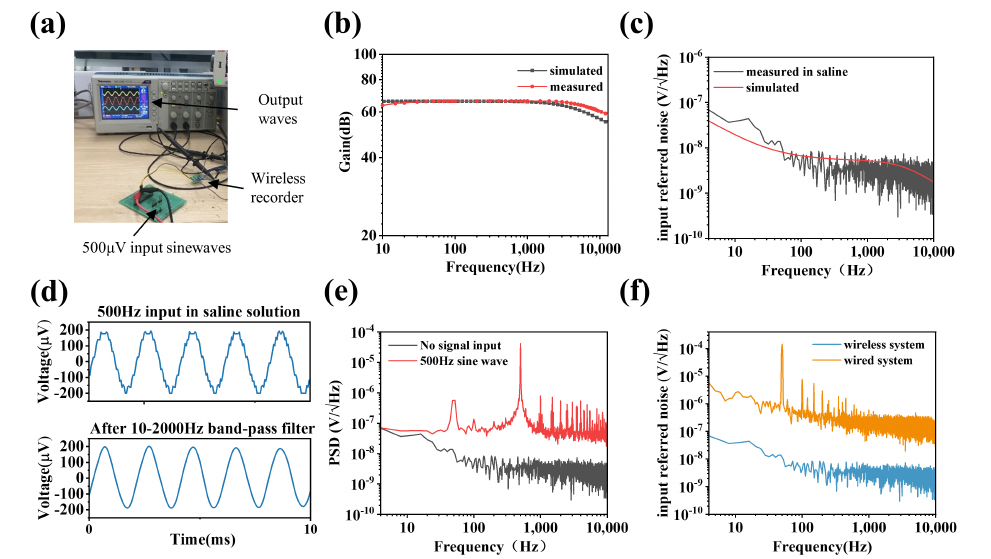
Figure 5. The electrical properties of wireless neural recording microsystem. ( a ) The transfer function test environment. ( b ) Transfer function measured and simulated of the dual op − amps full differential neural recording front end. ( c ) Input referred noise measured of the wireless neural recording microsystem in saline solution and compared with the simulation. ( d ) The waveform of recorded 500 Hz, 2 mV signal injected in the saline by the wireless neural recording microsystem using 35 µ m diameter tungsten electrodes, and waveform after filtering out high − frequency interference. ( e ) Power spectral density in saline with or without 500 Hz input signal. ( f ) Input referred noise comparison of wireless recording microsystem and Apollo II wired recording